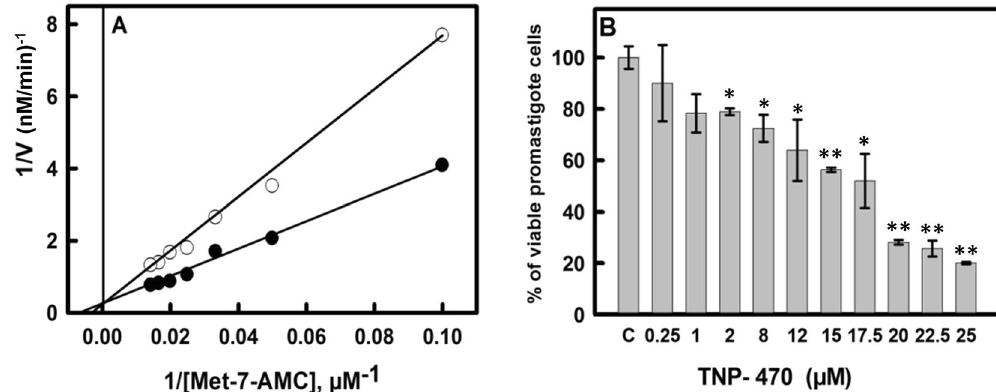
Figure 1. Lineweaver-Burk plot and Cell proliferation assay in presence of MAP2 inhibitor, TNP-470. ( A ) Inhibition studies for TNP-470 (100 µ M), Competitive inhibition with respect to Met-AMC as a substrate. Ki value was found to be 13.5 nM. ( B ) MTT Assay; Effect of TNP-470 on L. donovani promastigotes, IC 50 value against L. donovani promastigotes were found to be 15.01 ± 0.73 µ M. Data represents the mean ± SD of three independent experiments . Statistical analysis was done using Student’s unpaired t-test in SigmaPlot software ( * denotes p value ≤ 0.05 and ** denotes p value <